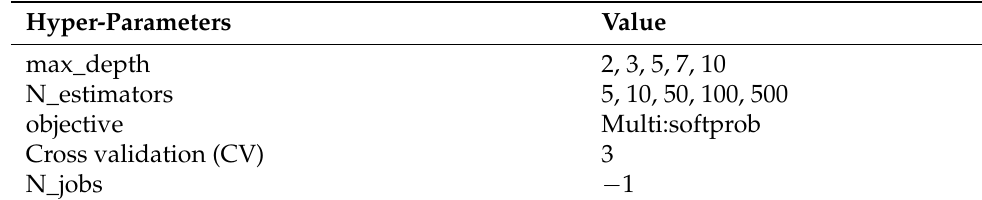
Table 10. Input Parameters for XGBoost.